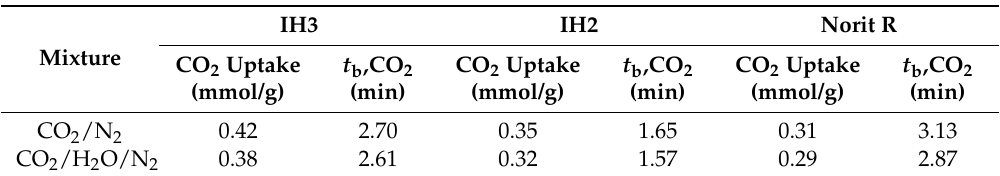
Table 6. Average CO 2 uptakes and breakthrough times calculated from the breakthrough adsorption cycles feeding ternary CO 2 /H 2 O/N 2 gas